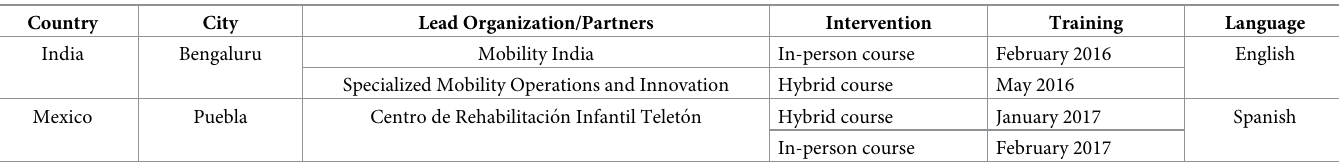
Table 1. List of settings and lead